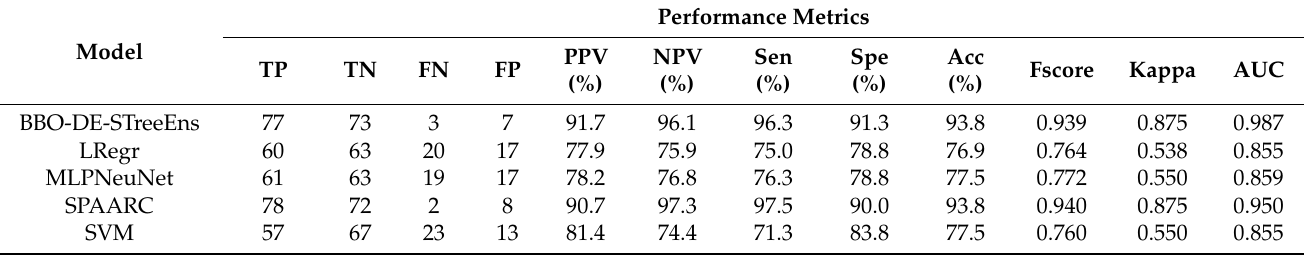
Table 1. Performance metrics of the proposed BBO-DE-STreeEns model and the benchmarks on the training